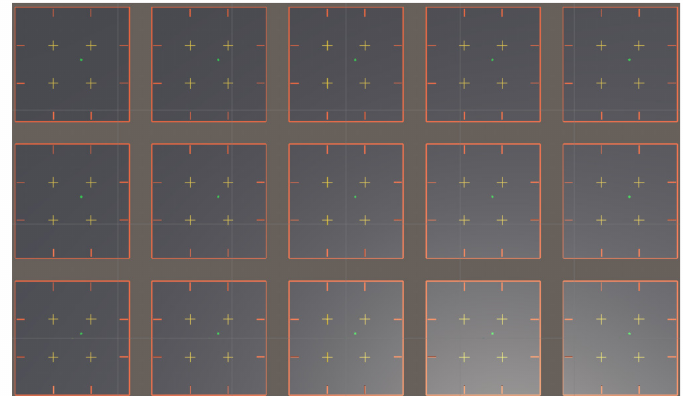
Figure 8. Real training environment in the Unity